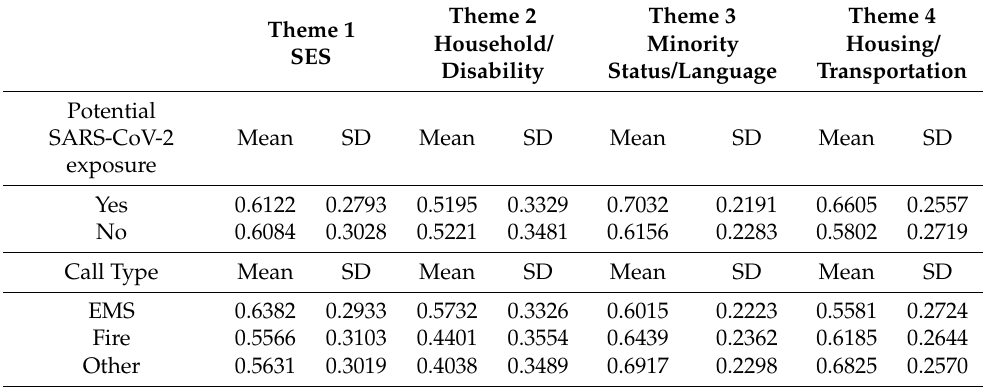
Table 3. Thematic vulnerability by SARS-CoV-2 exposure and emergency response call type.